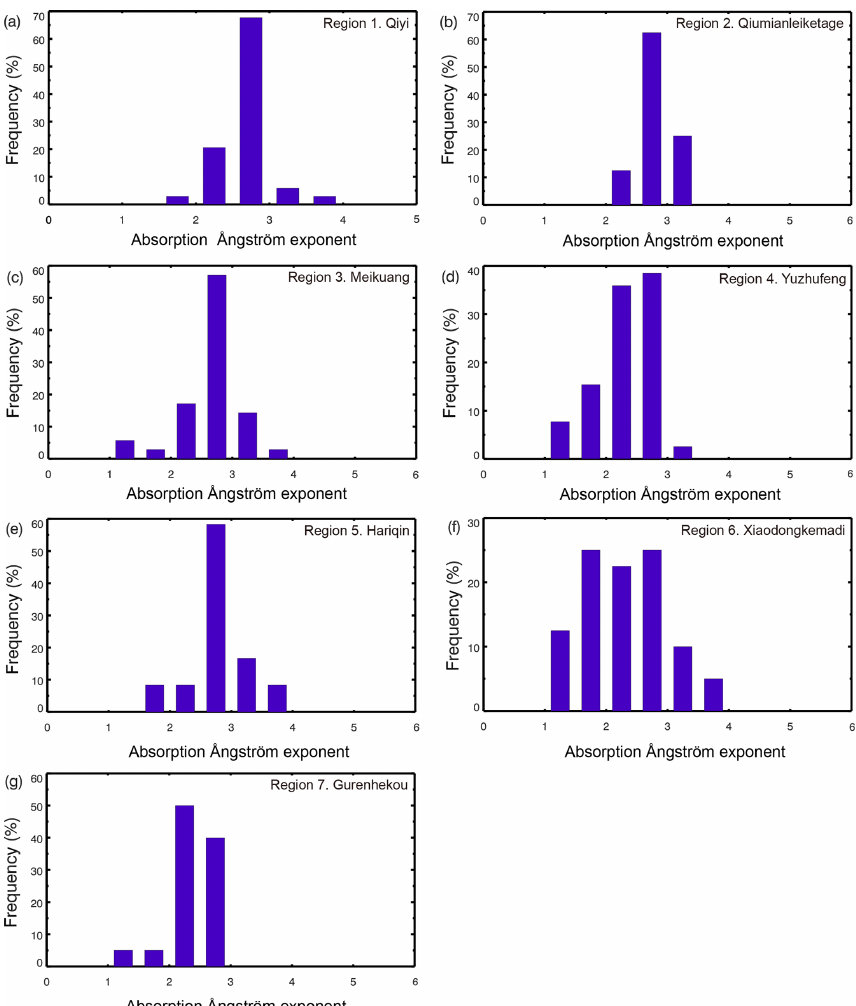
Figure 5. Histograms of the frequency of Å tot (450–600nm) in ice from each glacier. Samples from all vertical profiles are